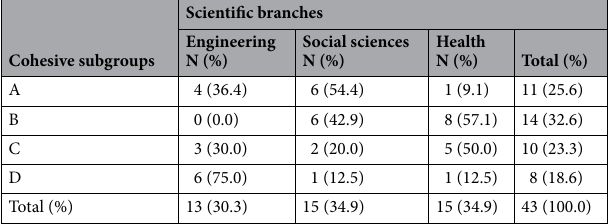
Table 4. The relationship of actors belonging to the different cohesive subgroups and scientific branches of their members.